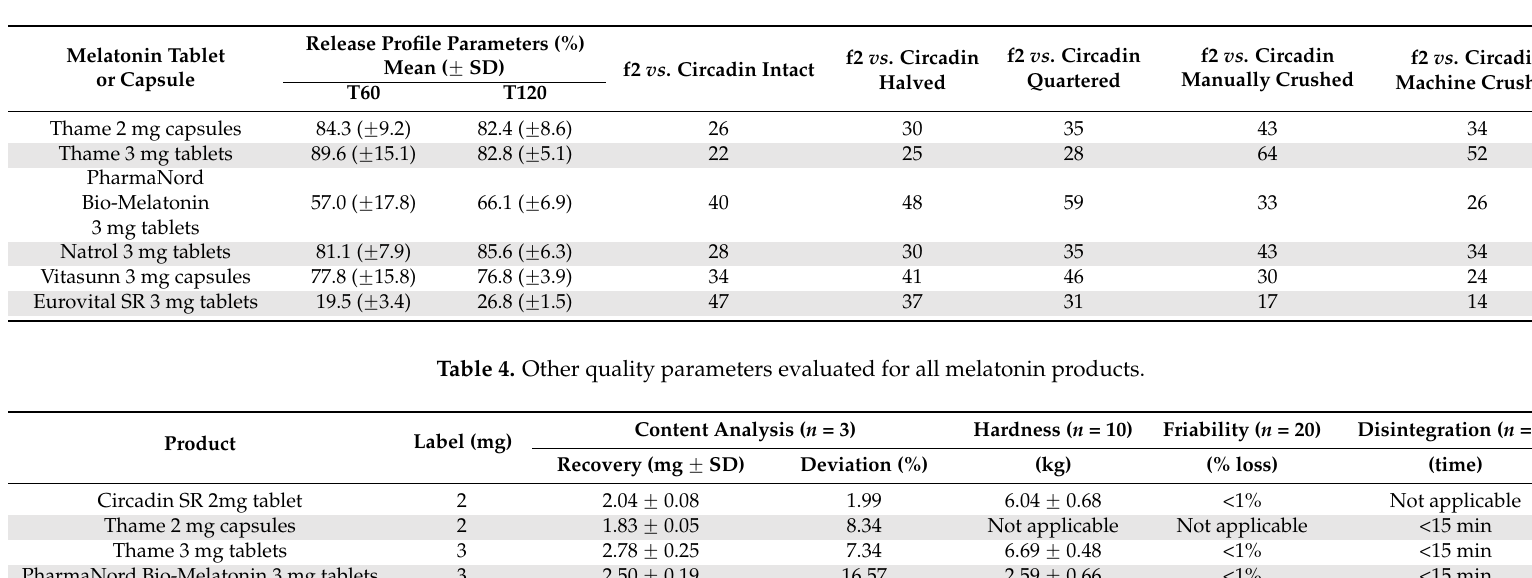
Table 3. Kinetics of melatonin release and comparison of dissolution profiles using the f2 similarity factor (>50 indicates similarity) for melatonin tablet and capsule products ( n = 3).